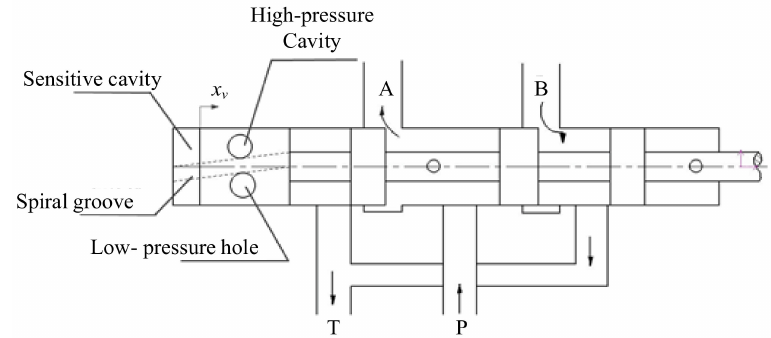
Figure 30. Working principle of 2D digital hydraulic valve.